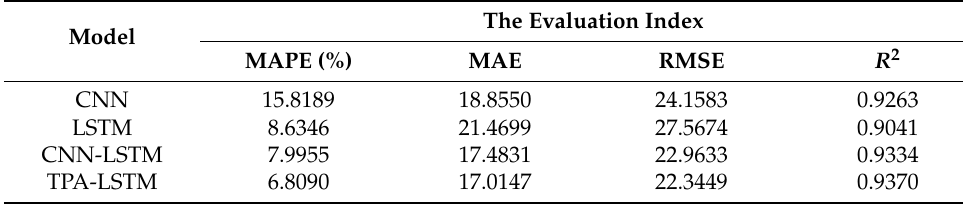
Table 3. Error analysis of prediction results of various models at Linping station.